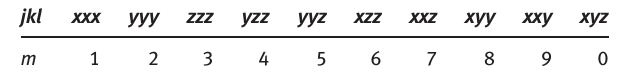
Table 1: List of the second subscript “ m ” number meaning in third- order susceptibility uses in Eq. (13) such as χ